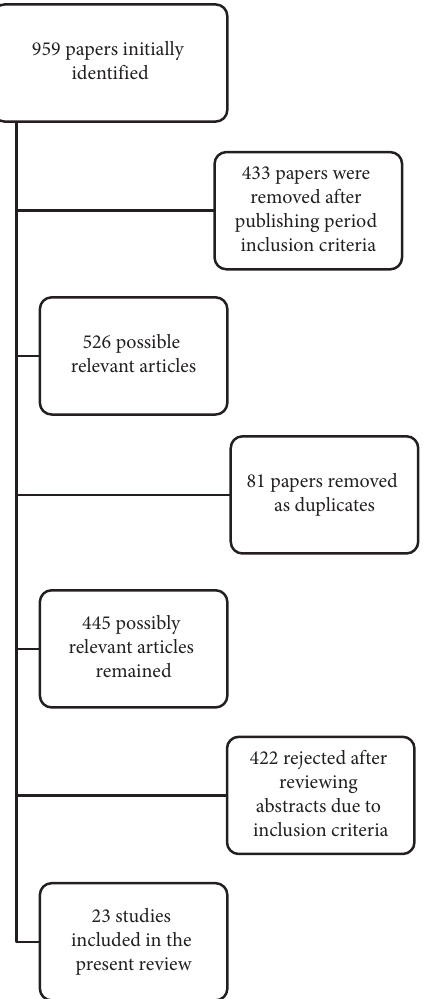
Figure 1: Flowchart of study